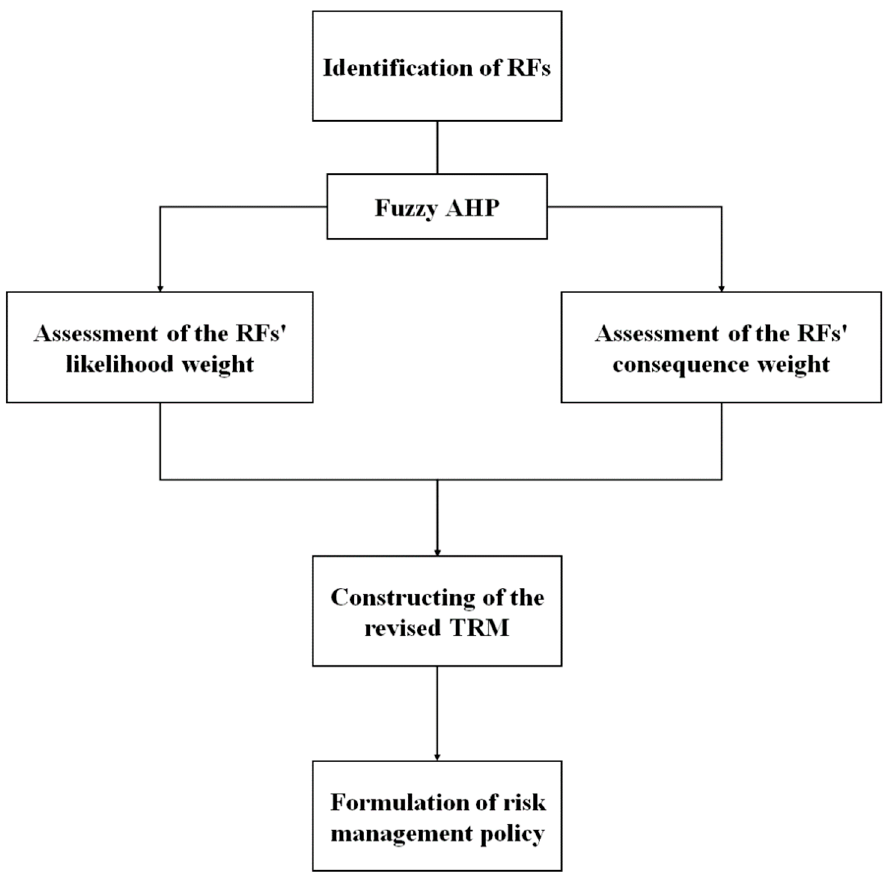
Figure 3. Research